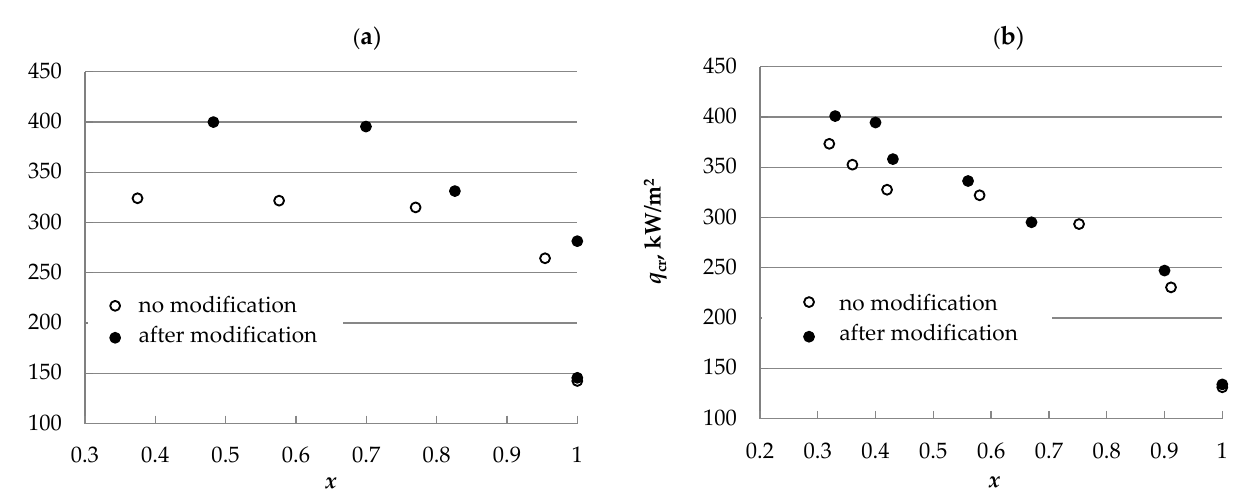
Figure 12. CHF data versus vapor quality, ( a ) p r = 0.43, ( b ) p r = 0.56.